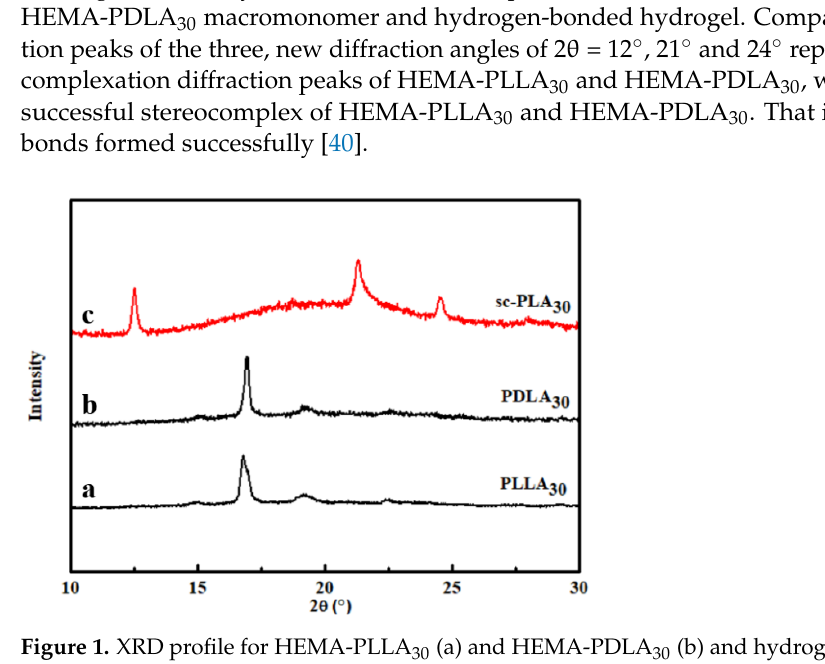
Figure 1. XRD profile for HEMA-PLLA 30 (a) and HEMA-PDLA 30 (b) and hydrogen-bonded hydrogel (c). gel